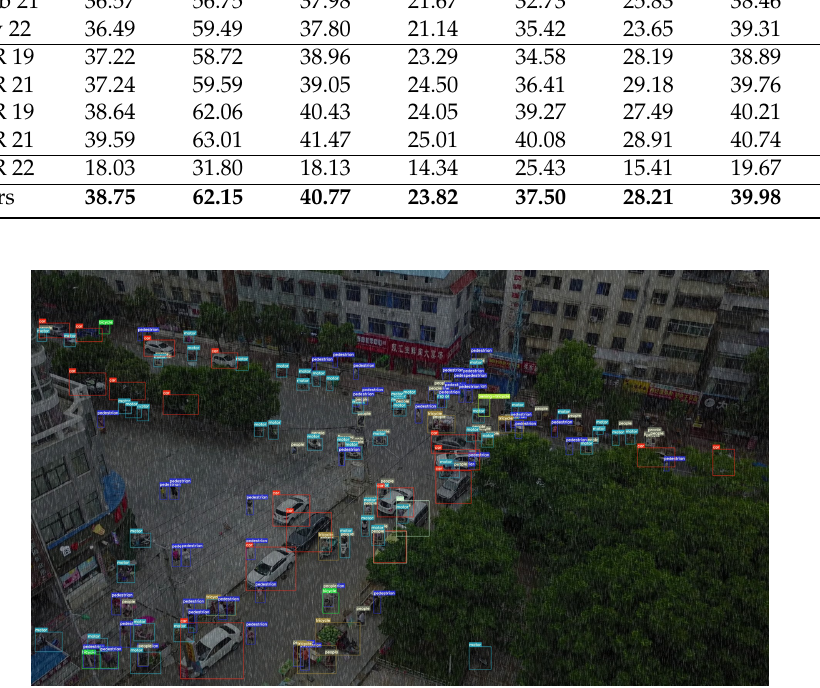
Figure 14. Visualization of detection results by CoDerainNet on a heavy rainy image in RainVisDrone.